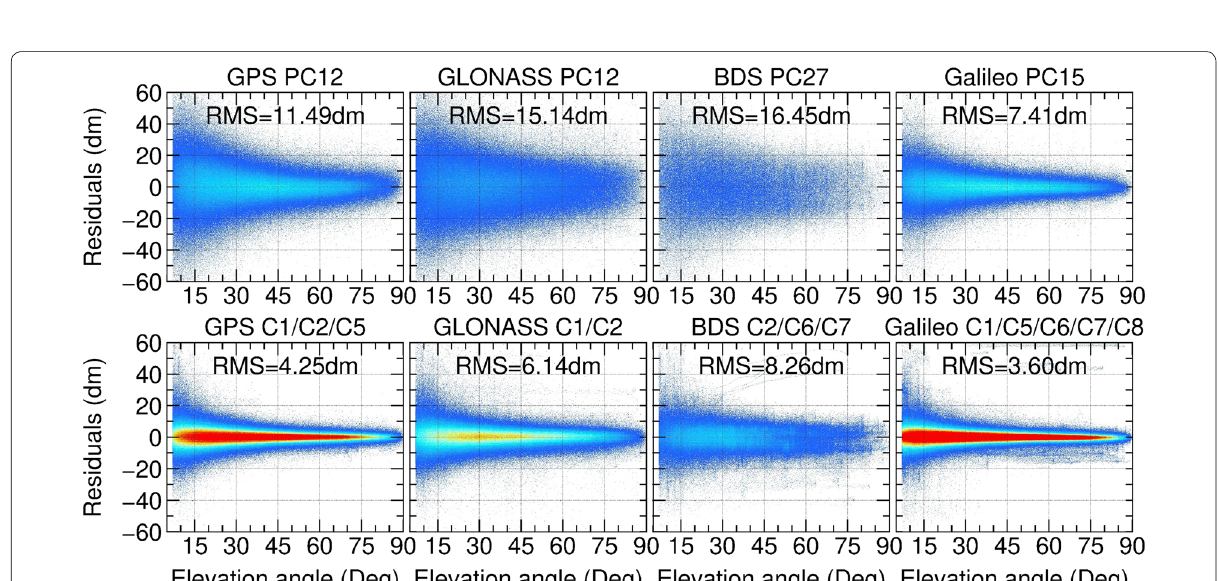
Fig. 2 Post-fit code residuals for the raw and IF observations; the color from blue to red indicates an increase in density. C1/C2… denote the code observations on different frequencies; PC12, PC27, and PC15 represent the observations of IF combination at frequencies 1, 2 and 2, 7 and 1, 5,